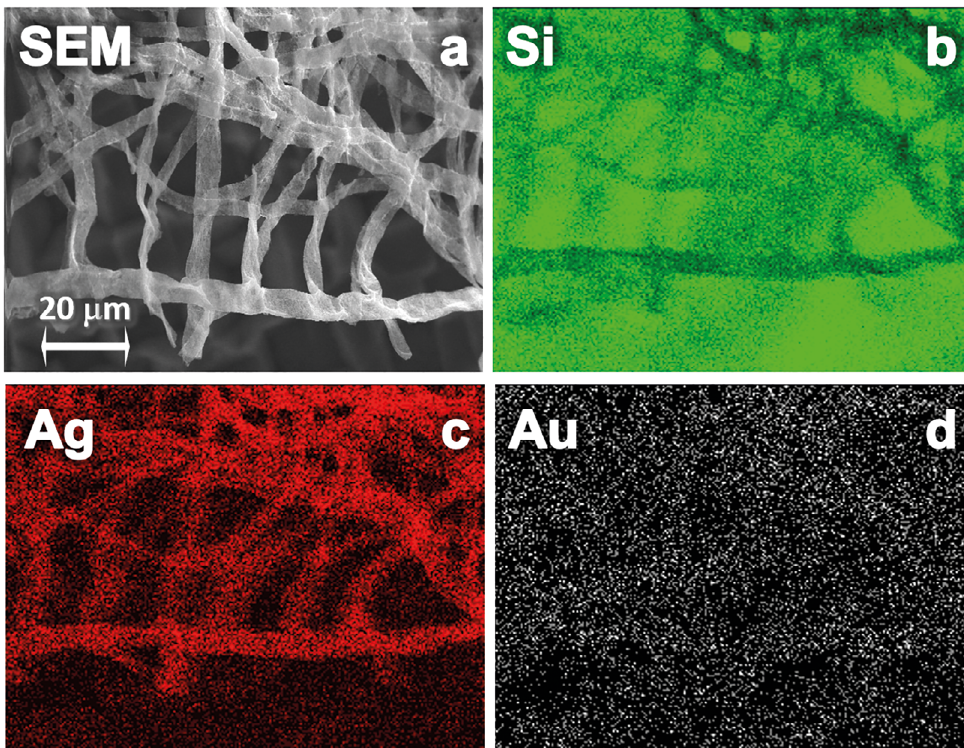
Figure 3. SEM images and EDX mapping in 2D of the elements (b) Si, (c) Ag and (d) Au that compose the filamentous fungus Aspergillus aculeatus localized in the center of the mycelial mass. Note that this region of fungus is covered solely with silver nanoparticles.